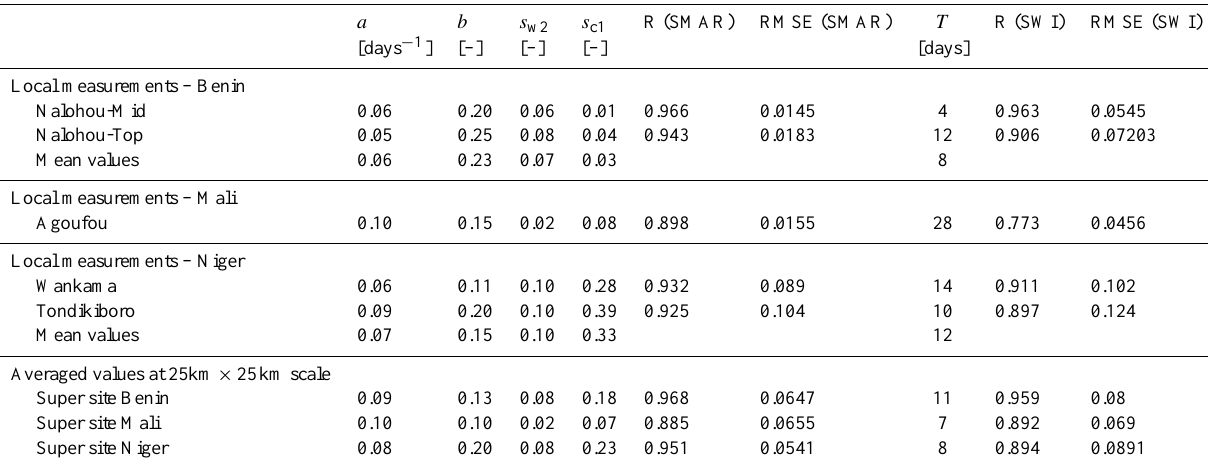
Fig. 7. Comparison between the relative saturation measured at 5cm ( s 1 ) and the averaged value in the second soil layer of depth ( s 2 ), the filtered value ( s ∗ ) obtained with SMAR and the filtered value obtained with the exponential filter ( s ∗ 2SMAR respectively in Benin (A) , Mali (B) , and Niger (C) . Results describe the application of SMAR and the exponential filter (SWI) method where all parameters have been calibrated optimizing the RMSE. Table 2. Summary of the results of the calibration with the SMAR and SWI methods on the time series of the AMMA database analysed